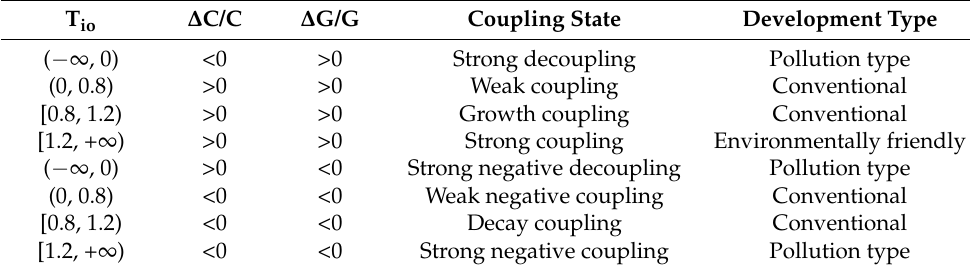
Table 4. Coupling indicator grade and elastic